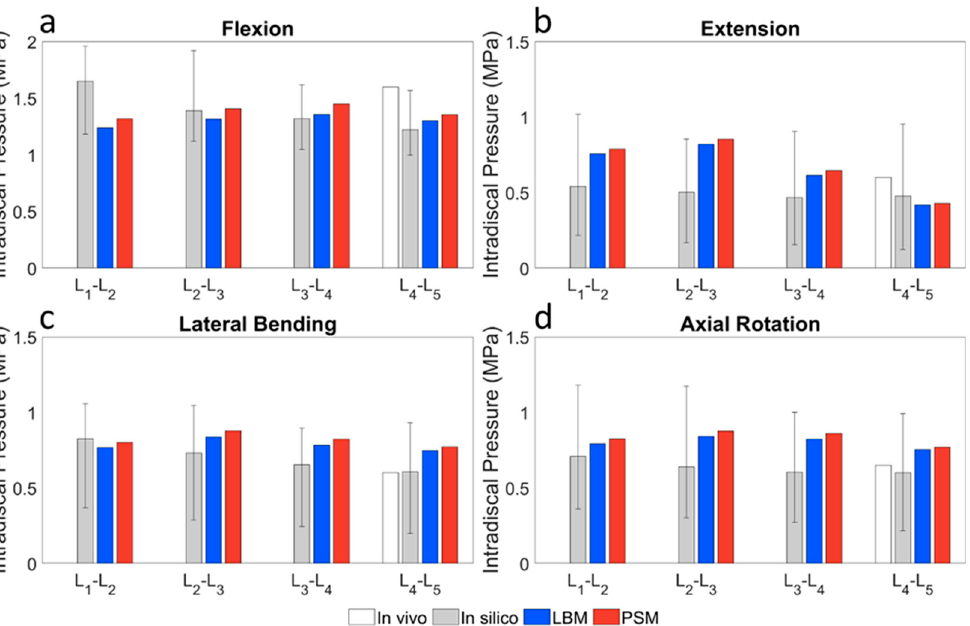
Figure 5. Predicted IDP values at different spinal levels for combined loads in ( a ) flexion, ( b ) extension, ( c ) lateral bending, and ( d ) axial rotation. The white bars correspond to the median values of an in vivo measurement [56]. The grey bars and their range illustrate the median and range of multiple validated and published FE models result [2].